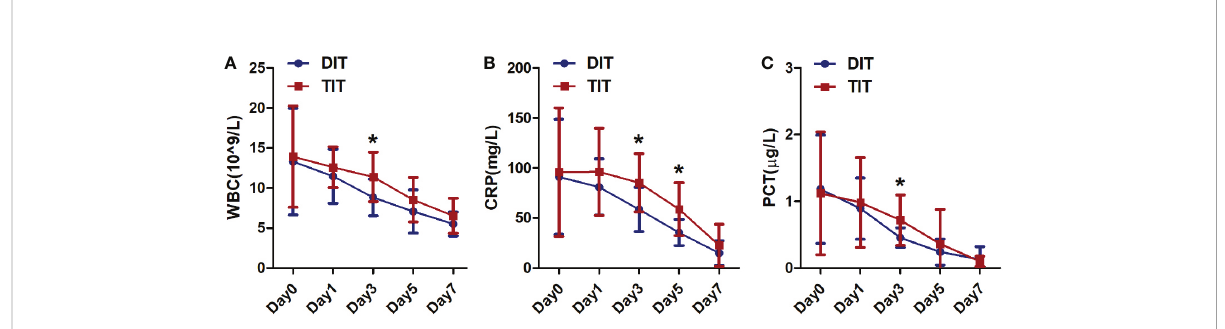
FIGURE 2 Comparison of levels of certain in fl ammatory indexes in the traditional intubation technique group and the deeper intubation technique group. (A) White blood cell count, (B) C-reactive protein, and (C) procalcitonin. * P<0.05.